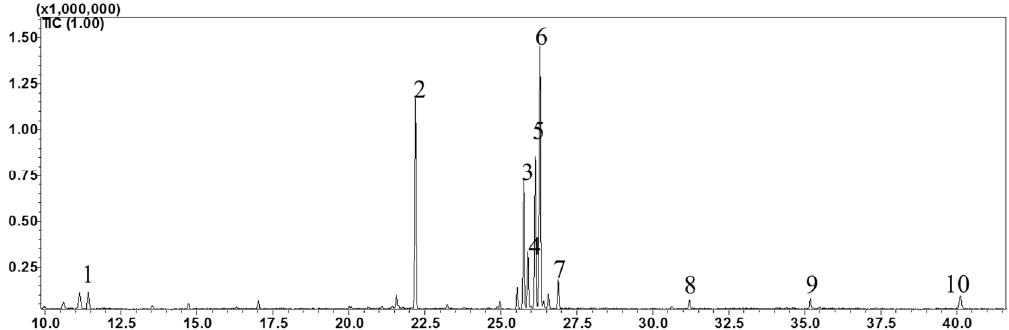
Figure 4. Gas chromatogram (GC) of fatty acid methyl esters (FAMEs) in the leaf tissues of Mertensia